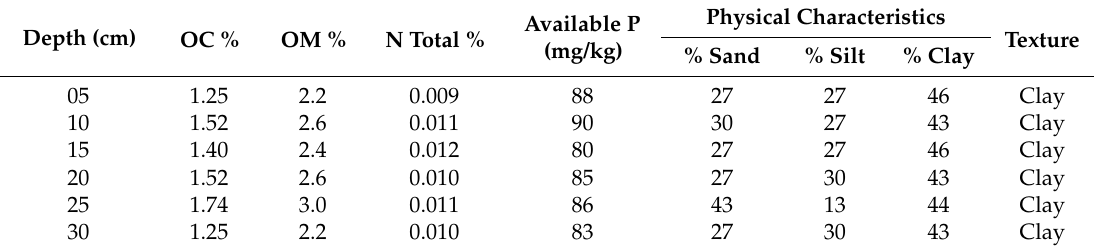
Table 1. Chemical and physical properties of the soil at the experimental site in Angónia, Tete.